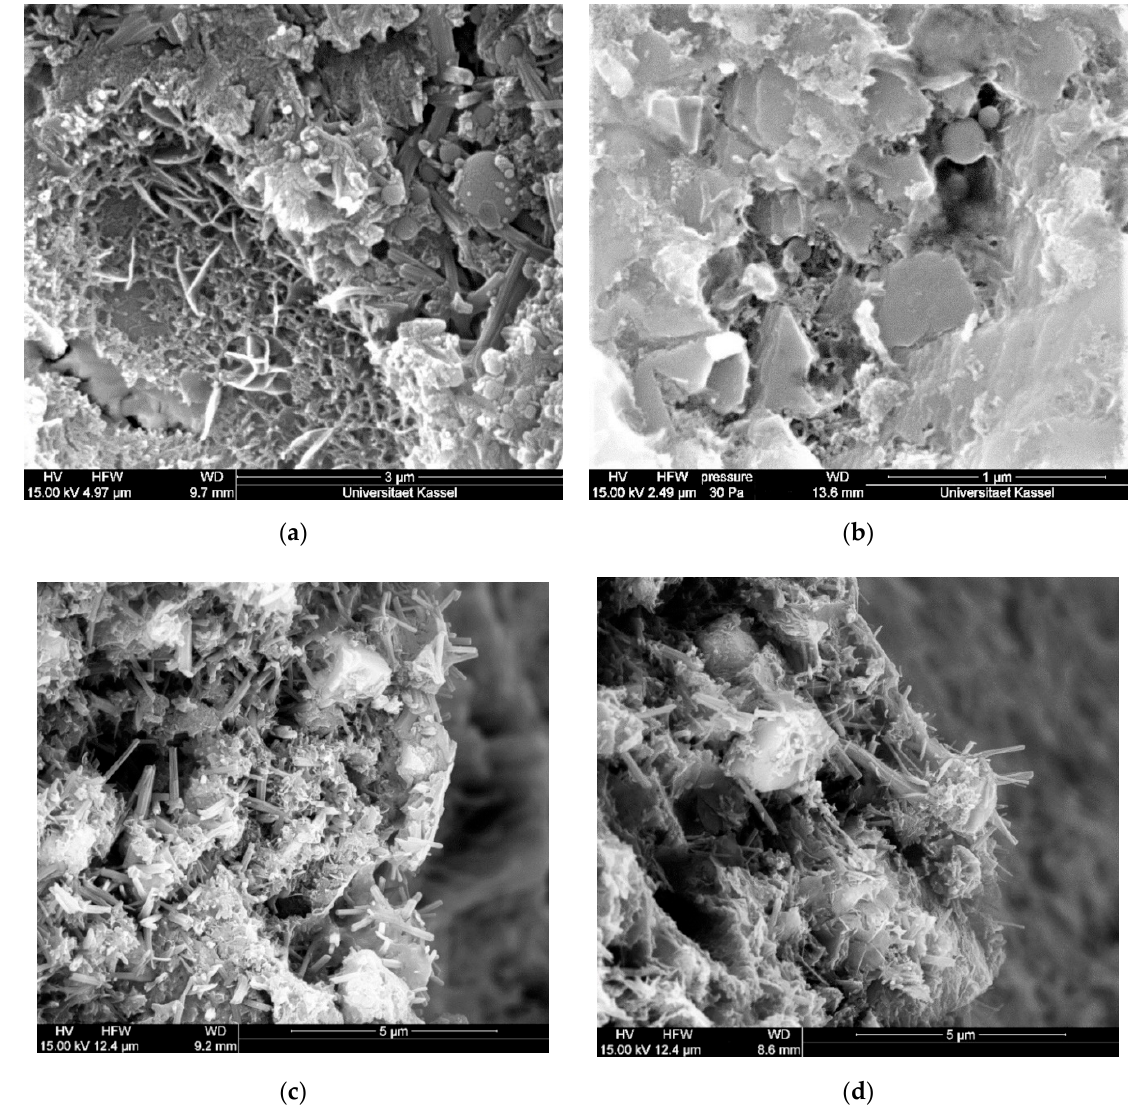
Figure 10. Monosulphate formation ( a ), C 3 AH 6 ( b ) and ettringite formation ( c ) in sample C7_4.50_75/25 and ettringite formation ( d ) in sample C7_4.50_25/75.